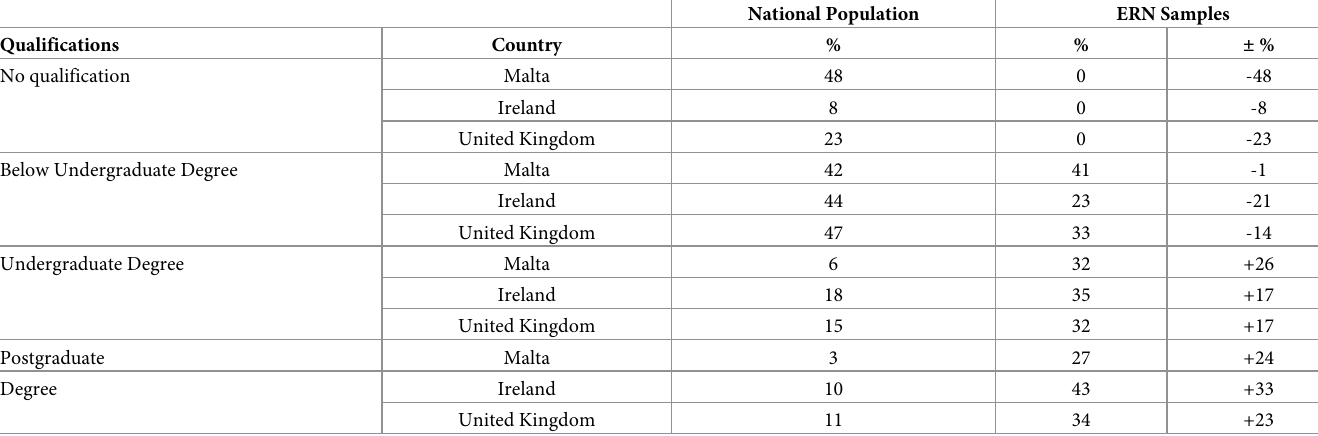
Table 4. Comparison of educational attainment of national population and participating ERN audiences.